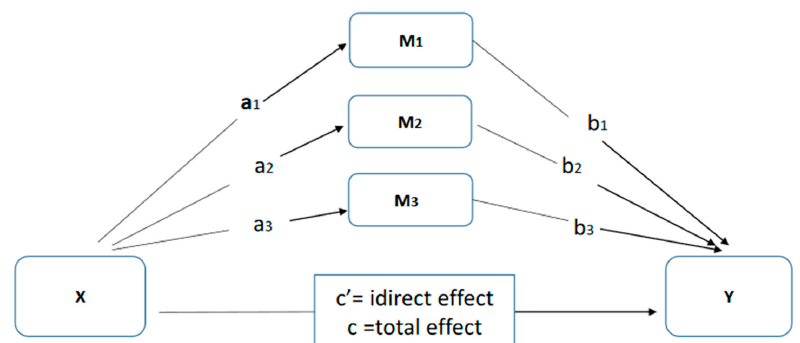
Figure 1. Illustration of a multiple mediation design. Path c represents the relationship between X and Y (total effect). The total effect is the sum of the direct and the indirect effect (c = c’ + a × b). Path c’ (direct effect) represents the relationship between X and Y when controlling for M (mediators).